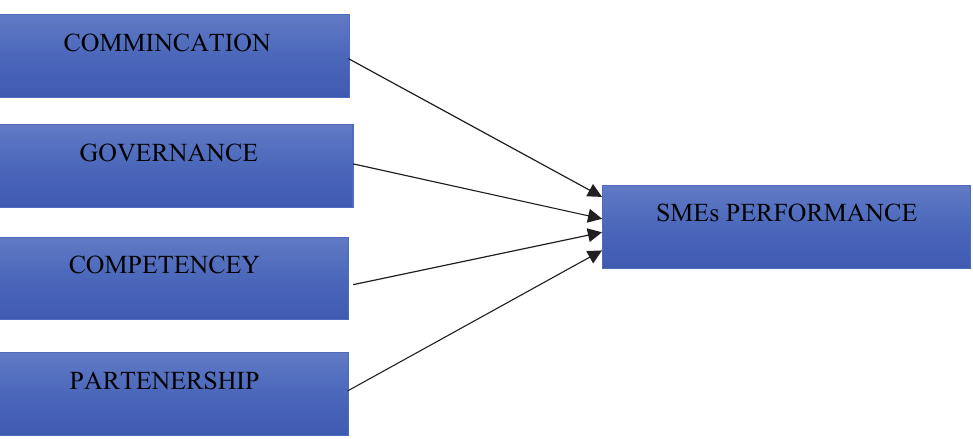
Fig. 1. Model of IT Business Alignment factors, SMEs